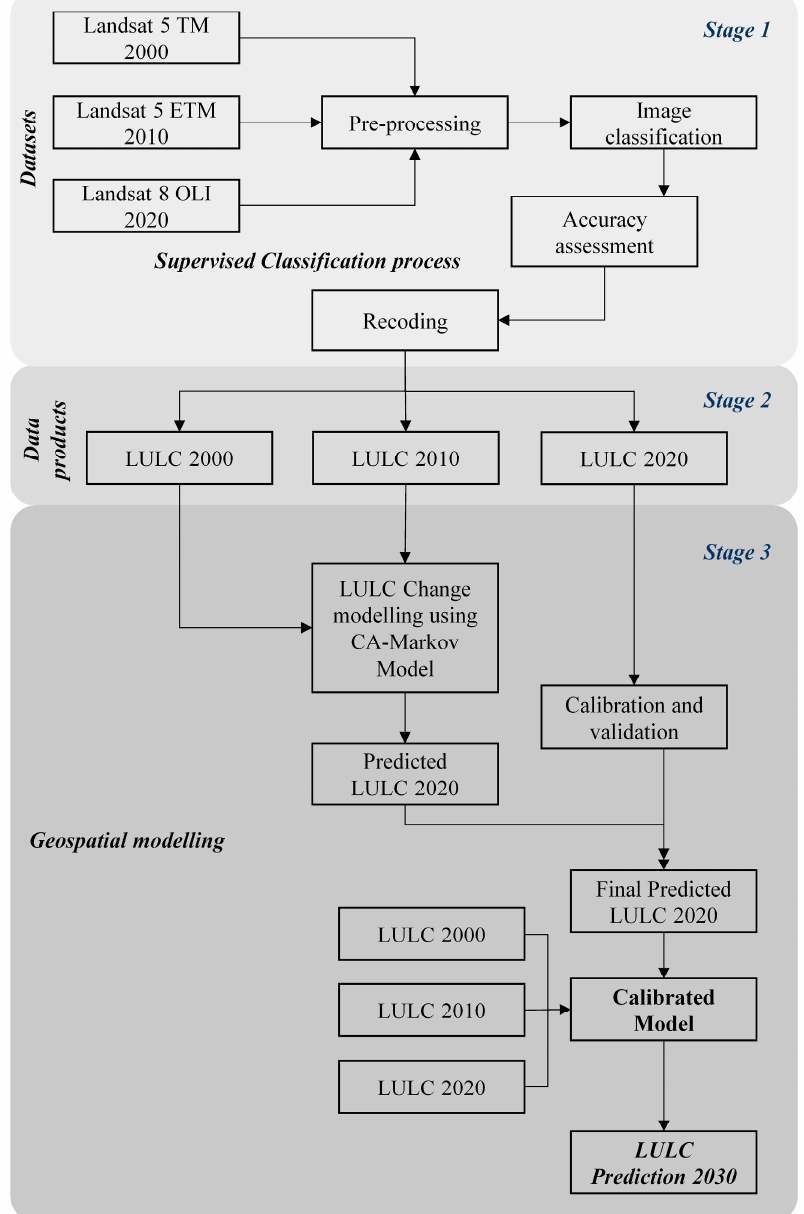
Figure 2. The overall methodology used to predict futuristic LULC.